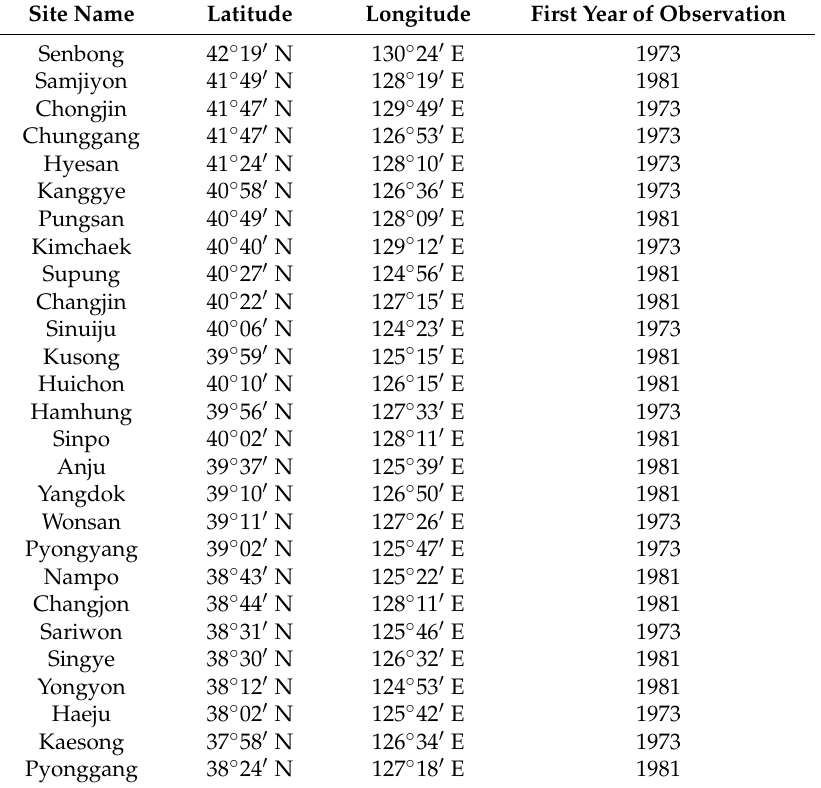
Table 2. Weather observation sites in North